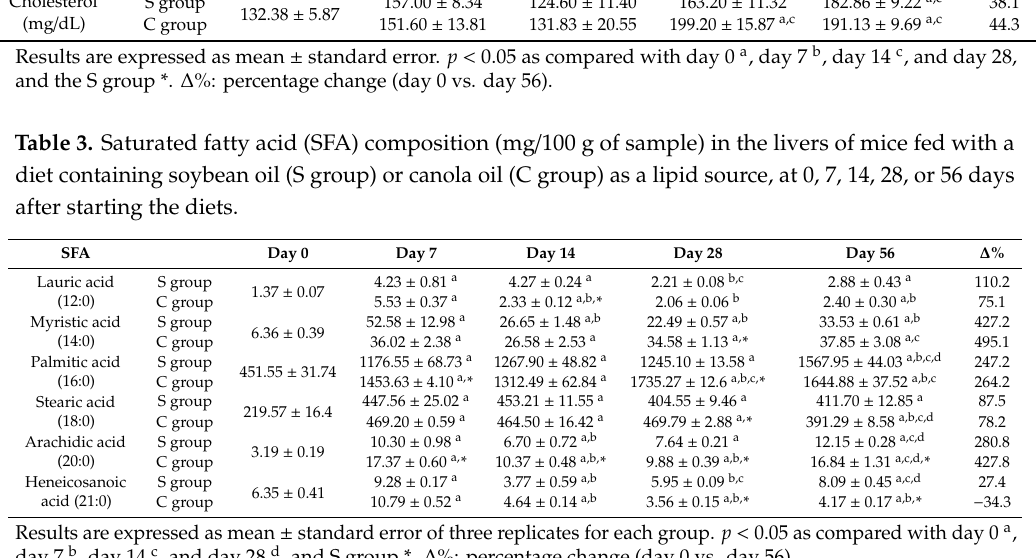
Linoleic acid (18:2n-6), γ -linolenic acid (18:3n-6), 11,14-eicosadienoic acid (20:2n-6), and arachidonic acid (20:4n-6) increased (p < 0.05) in both groups (day 56 vs. day 0). On day 56, the C group exhibited lower ( p < 0.05) levels of linoleic acid (18:2n-6), γ -linolenic acid (18:3n-6), and arachidonic acid (20:4n-6) in comparison with the S group. In contrast, the C group showed higher ( p < 0.05) levels of 11,14-eicosadienoic acid (20:2n-6) on day 56 (Table